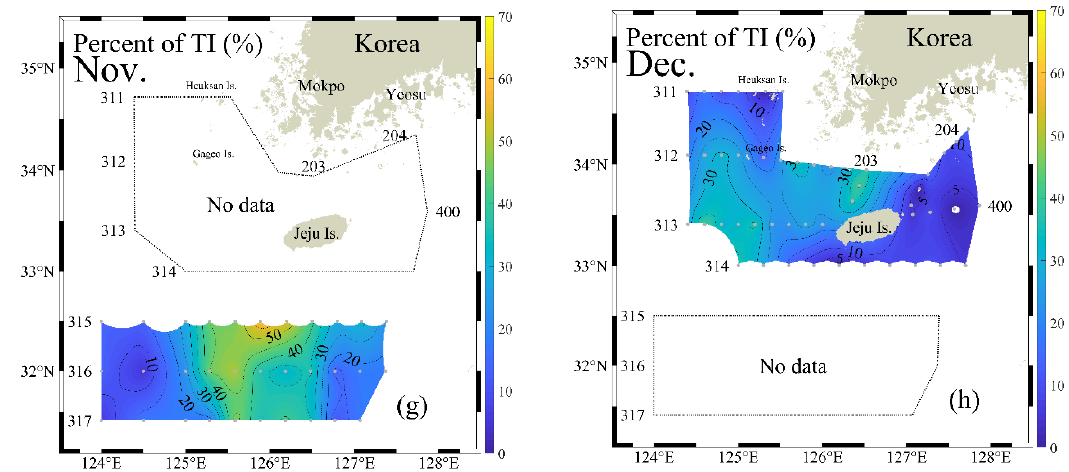
Figure 3. Percent of occurrences of water temperature inversion layer in the North East China Sea during 1995 to 2016 in February ( a ), April ( b ), May ( c ), June ( d ), August ( e ), October ( f ), November ( g ), and December ( h ).